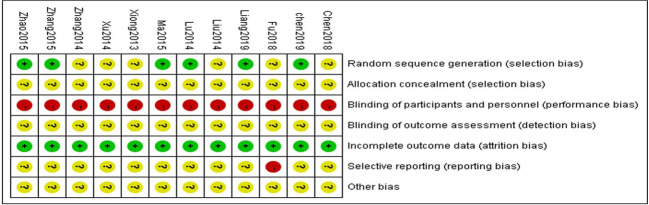
Graphs for risk of bias.